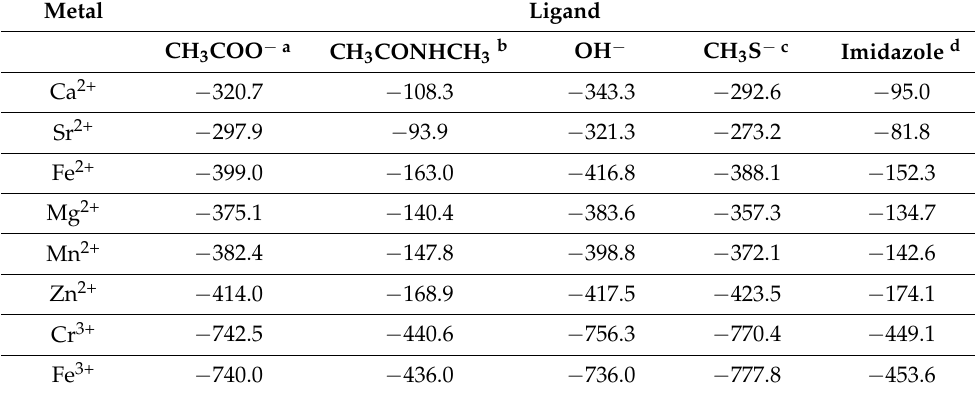
Gas-phase energies of formation (in kcal/mol) of single-metal ligand complexes (metal = Ca 2+ , Sr 2+ , Fe 2+ , Mg 2+ , Mn 2+ , Zn 2+ , Cr 3+ , Fe 3+ ) from M06-2X/6-311++G**